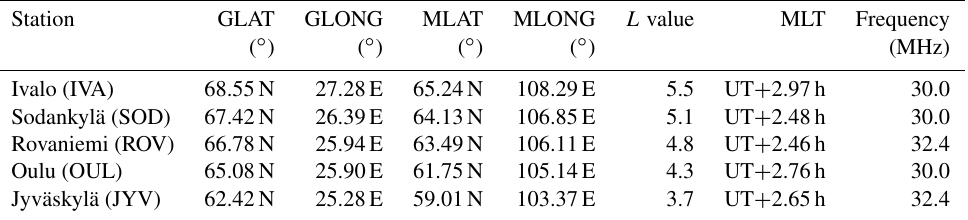
Table 1. Summary of the riometers used in this study. The station name and abbreviation, geographic latitude and longitude (GLAT and GLONG), geomagnetic latitude and longitude (MLAT and MLONG) as computed from the International Geomagnetic Reference Field (IGRF) 2008 model, L value, MLT time in relation to universal time (UT) at different stations, and frequency.